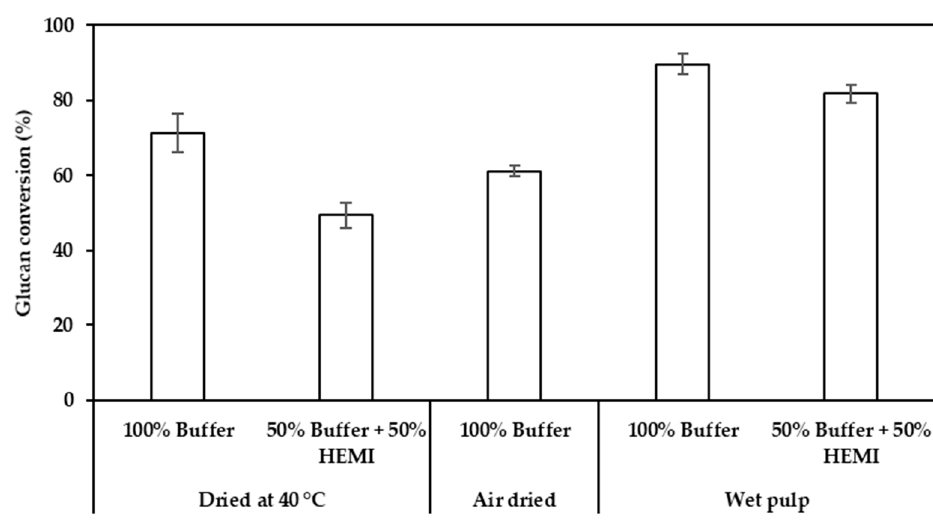
Figure 3. Conversion yields of glucan under di ff erent sample preparation strategies, namely, oven-dried at 40 ◦ C, air-dried, and used in wet form. “HEMI” stands for the hemicellulosic compound-rich fraction obtained after evaporation.